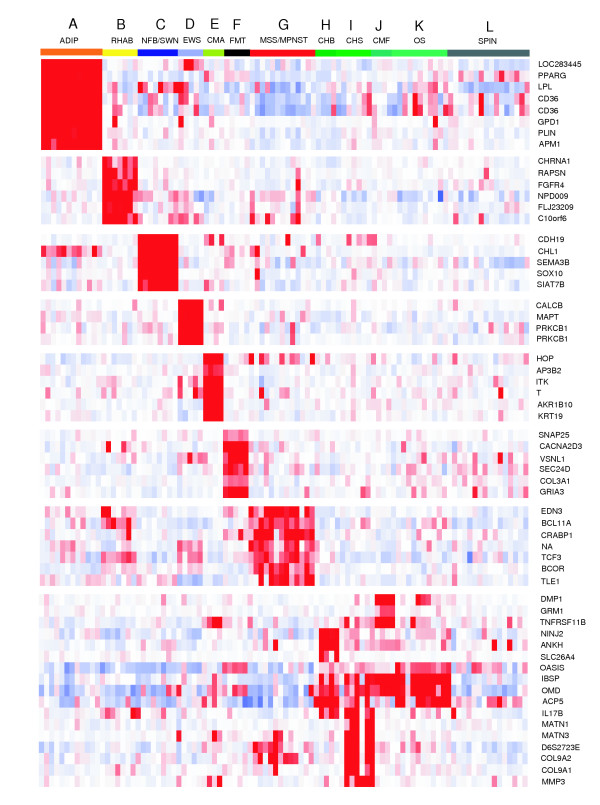
Pathognomonic fingerprints for many tumor types. In step one of our model, 61 genes were used in all folds of cross-validation. Average linkage clustering of this geneset reveals strong sets of distinct genes for many single mesenchymal tumors or composite groups. The sample types are color coded as before. A, adipocytic tumors; B, rhabdomyosarcoma; C, NFB/SWN; D, EWS; E, CMA; F, FMT; G, MSS/MPNST; H, CHB; I, CHS; J, CMF; K, OS; L, spindle-like tumors.